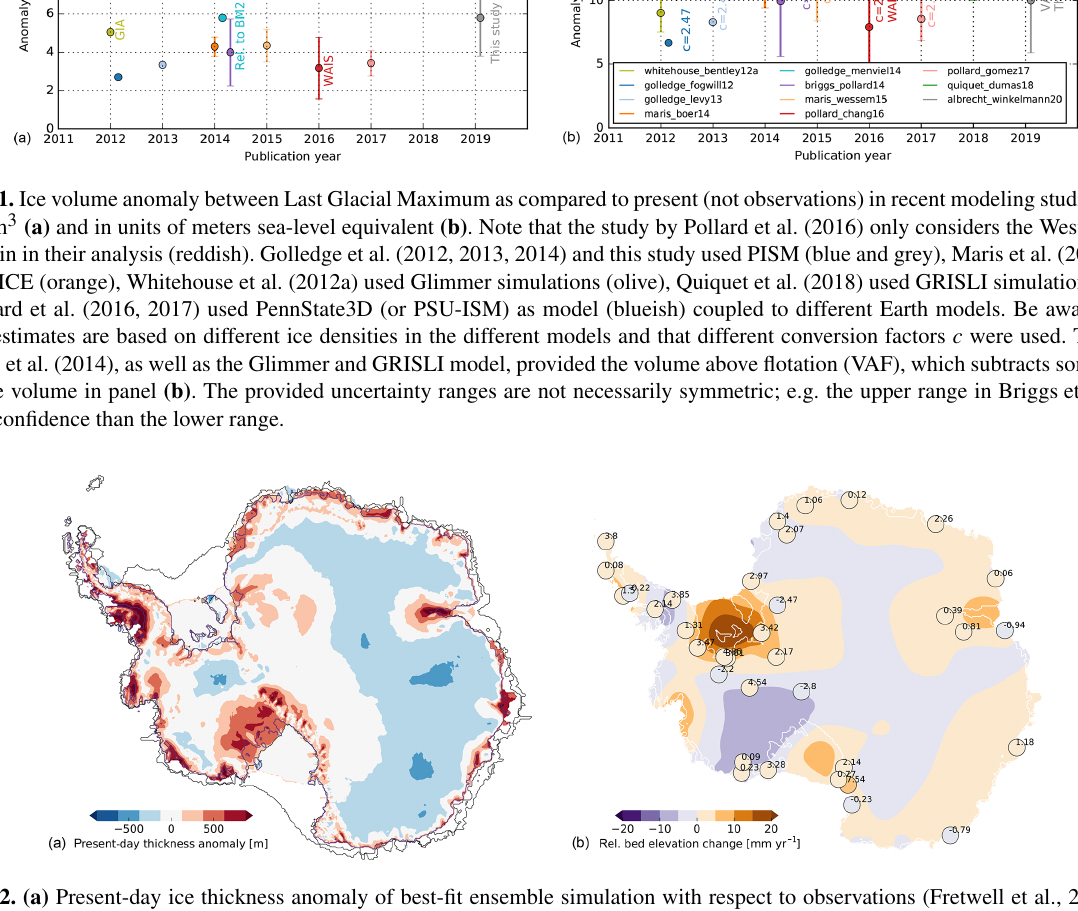
Figure 12. (a) Present-day ice thickness anomaly of best-fit ensemble simulation with respect to observations (Fretwell et al., 2013), with the continental shelf in grey shades. Blue line indicates observed grounding line, while black lines indicate modeled grounding line and calving front. Large areas of the East Antarctic Ice Sheet are underestimated in ice thickness, while some marginal areas along the Antarctic Peninsula, Siple Coast and Amery Ice Shelf are thicker than observed, with a total RMSE of 266m. (b) Modeled uplift (violet) and depression (brown) at present-day state as compared to uplift rates from recent GPS measurements (Whitehouse et al., 2012b) in 35 locations (in units mmyr − 1